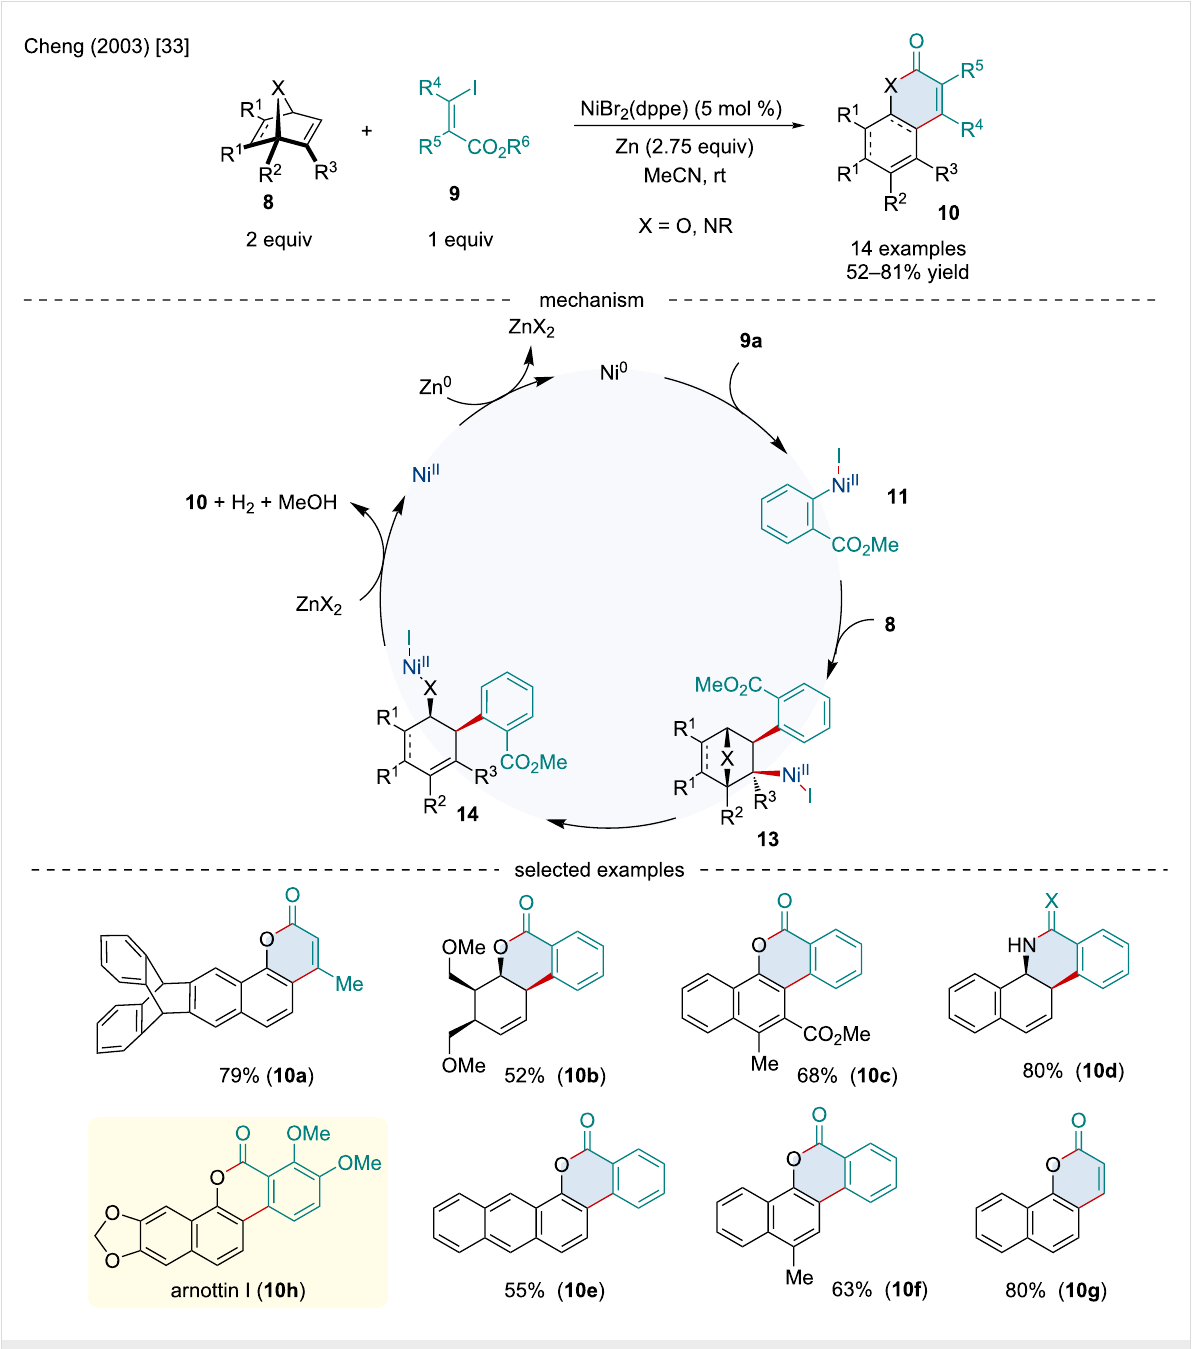
Scheme 2: Ni-catalyzed ring-opening/cyclization cascade of heterobicyclic alkenes 8 with β -iodo-(Z)-propenoates and o -iodobenzoates 9 .